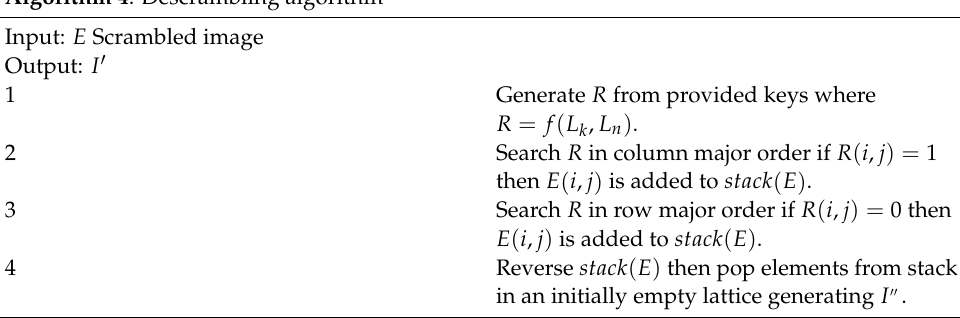
Algorithm 4 : Descrambling